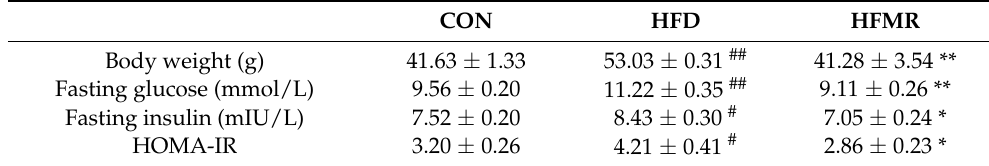
Table 1. Effects of MR on insulin resistance of HFD-induced obese mice.